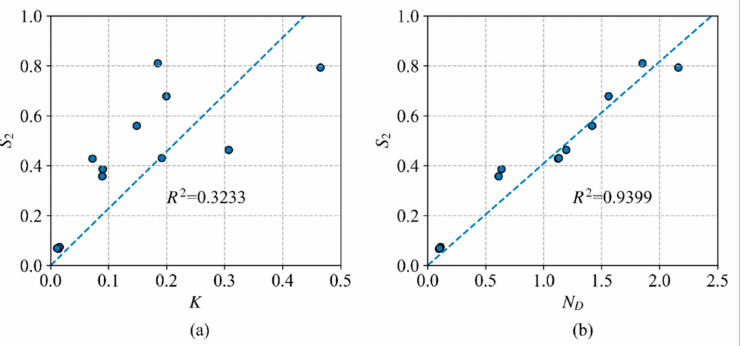
Figure 1. Plots of the correlation entropy S 2 versus K ( a ) and N D ( b ) for the transition states in the DBH24 datasets.